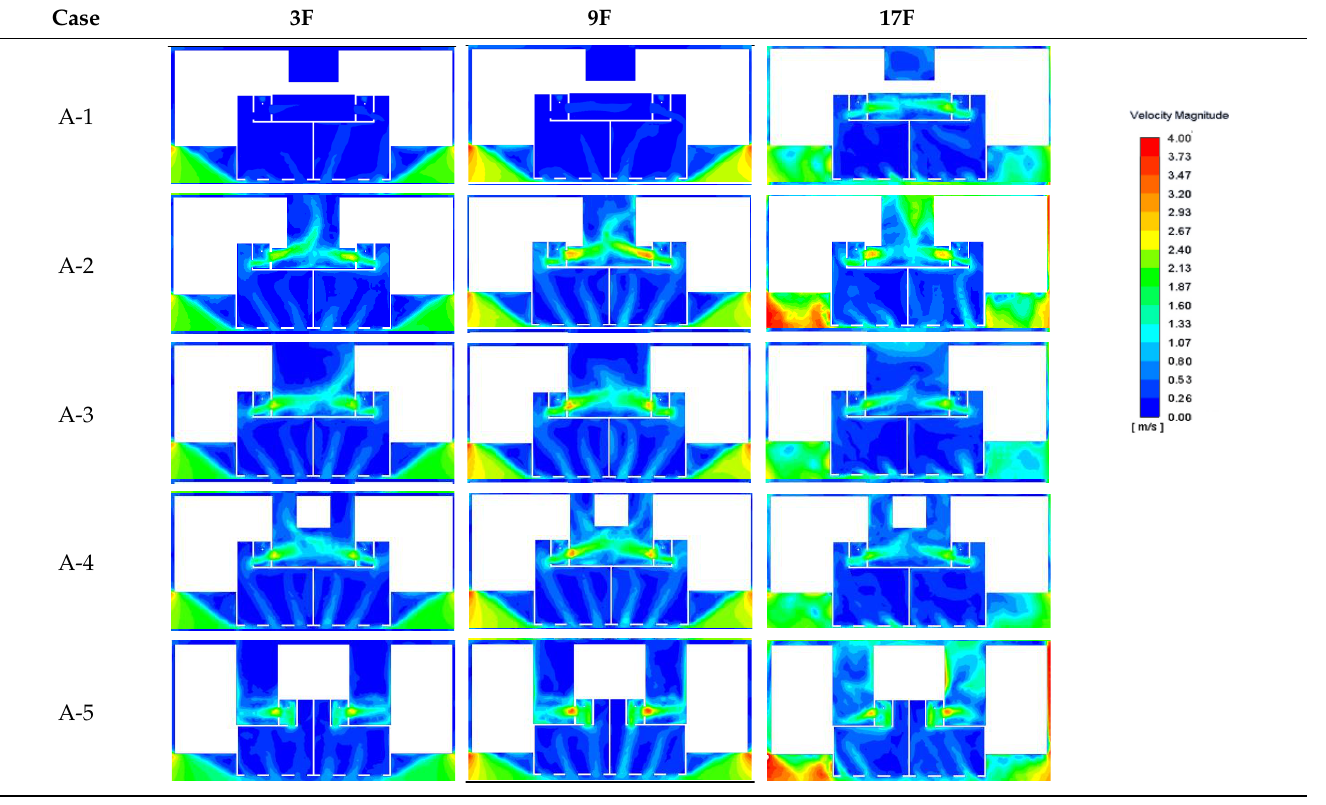
Figure 8. Analysis in kitchens for different inner-courtyard forms: ( a ) average air velocity; ( b ) aver- age PM2.5 concentration. Table 8. Air velocity simulation results for five inner-courtyard variables.